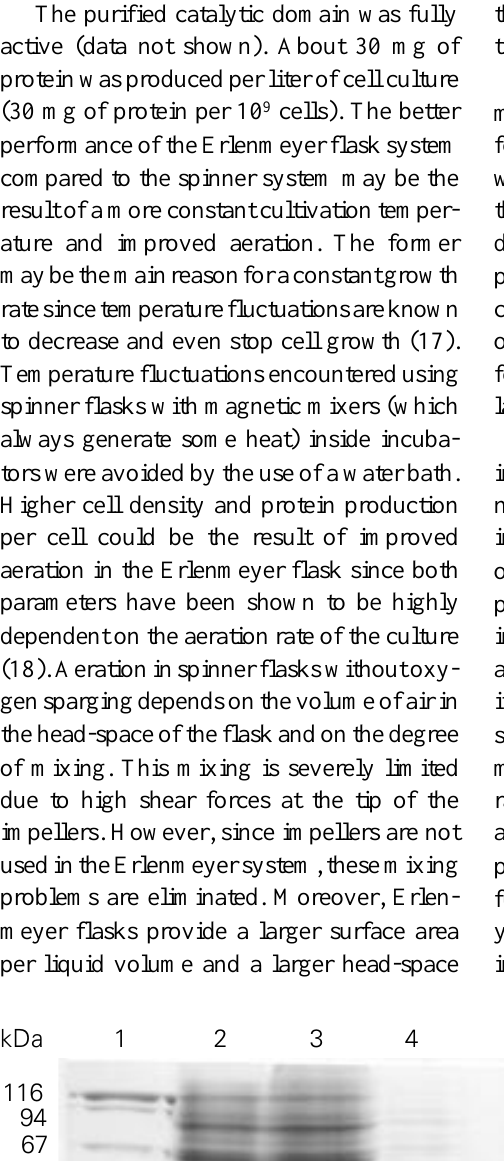
Figure 3 - Monitoring the purification of the recombinant 40-kDa domain of chicken PARP expressed with the baculovirus/insect cell system. Samples at various stages of purification were separated on 0.1% SDS-10% polyacrylamide gel (Coomassie blue stained). Lane 1 , Molecular mass markers ((cid:223)-galactosidase, 116 kDa; phosphorylase b, 94 kDa; serum albumin, 67 kDa; ovalbumin, 43 kDa; carbonic anhydrase, 30 kDa; trypsin inhibi- tor, 20 kDa); lane 2 , crude lysate; lane 3 , protamine sulfate precipitation; lane 4 , ammonium sulfate precipitation; lane 5 , 3- aminobenzamide affinity chromatography. The arrow indicates the position of the band correponding to the recombinant 40- kDa catalytic domain of chicken